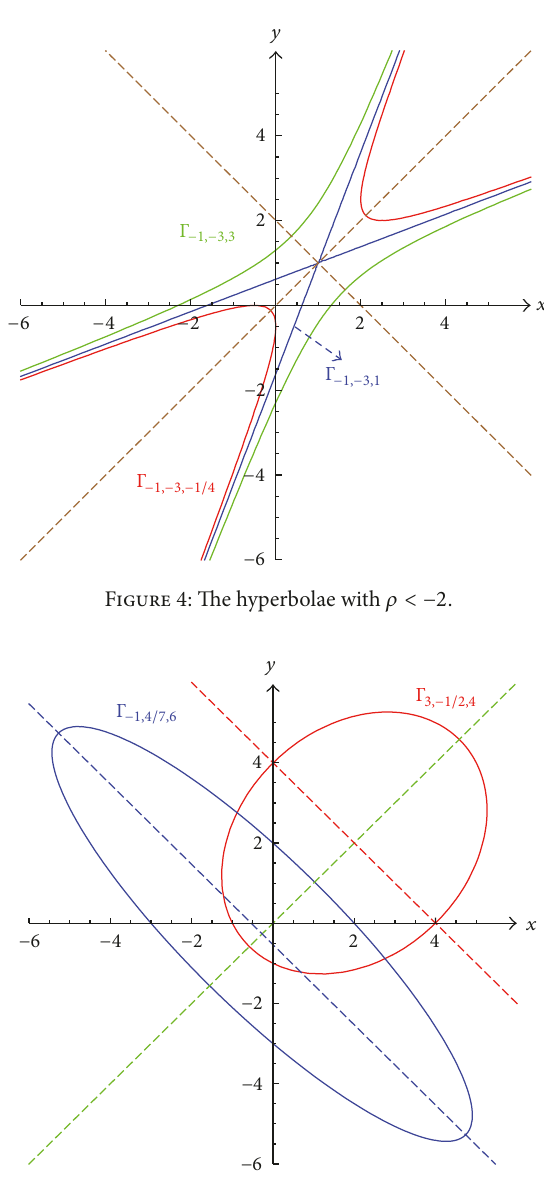
Figure 5: The ellipses with −2 < 𝜌 < 2 .